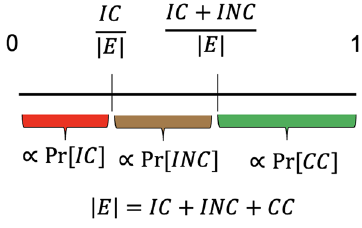
Figure 2. Decision boundaries for the simulation of the calls.